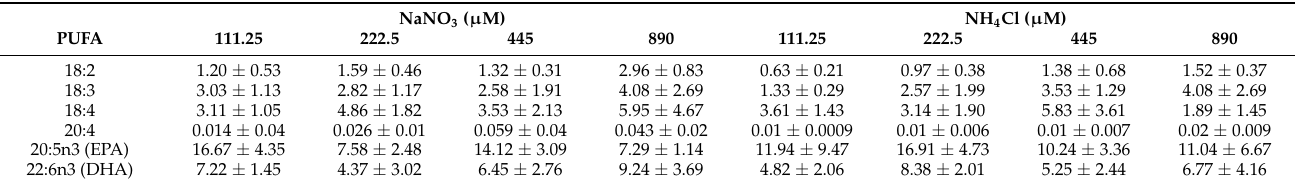
Table 5. Polyunsaturated fatty acid (PUFA), eicosapentaenoic acid (EPA) and docosahexaenoic acid (DHA) composition of Thalassiosira weissflogii growth in different nitrogen sources ( µ M) and concentrations in pg cells − 1 (mean ± SD). SD: standard